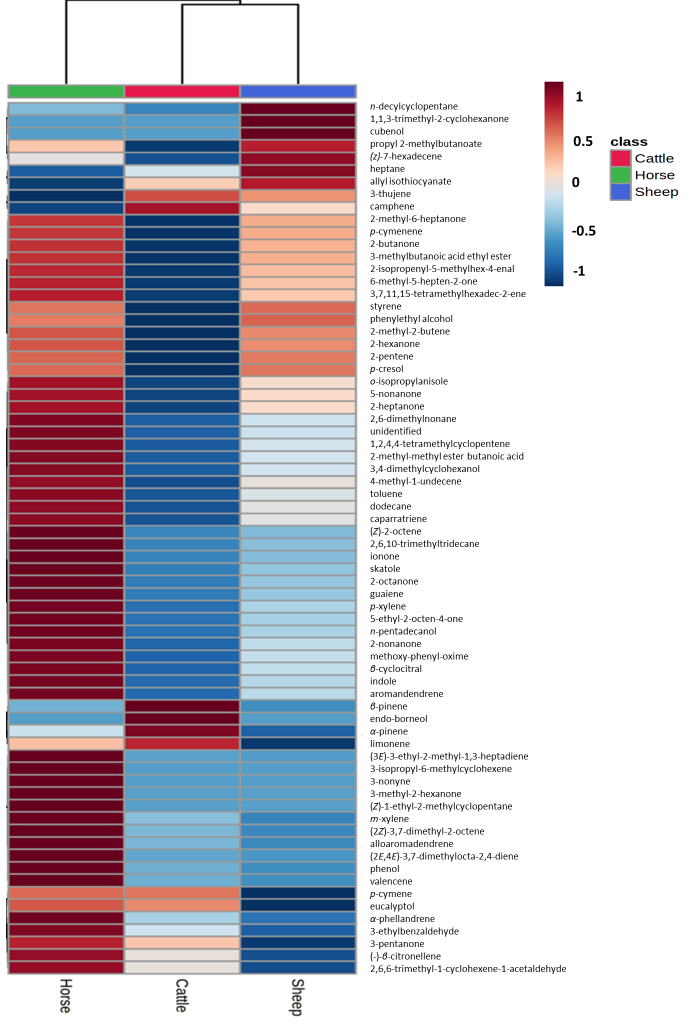
Figure 6. Hierarchical clustering of volatilomes of cattle, horse, and sheep dung based on the relative abundance of compounds identified in their respective headspaces (based on MZmine-produced feature list for statistical analysis).